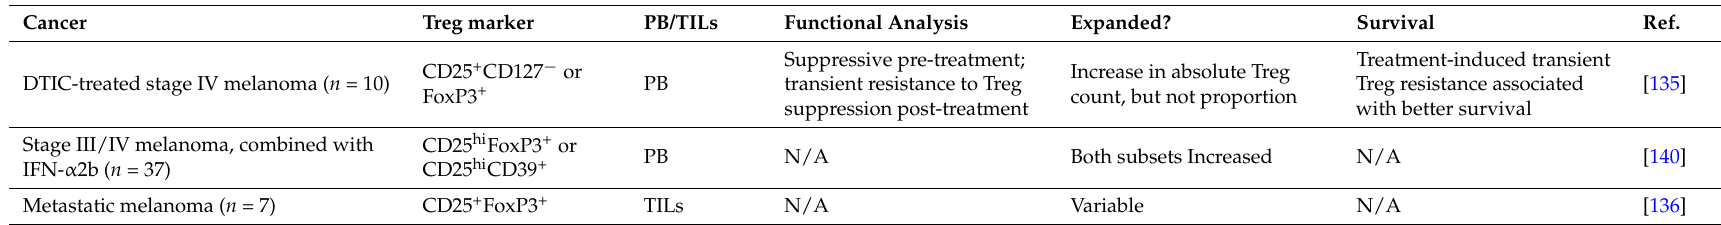
Table 3. Clinical studies investigating the impact of tremelimumab on